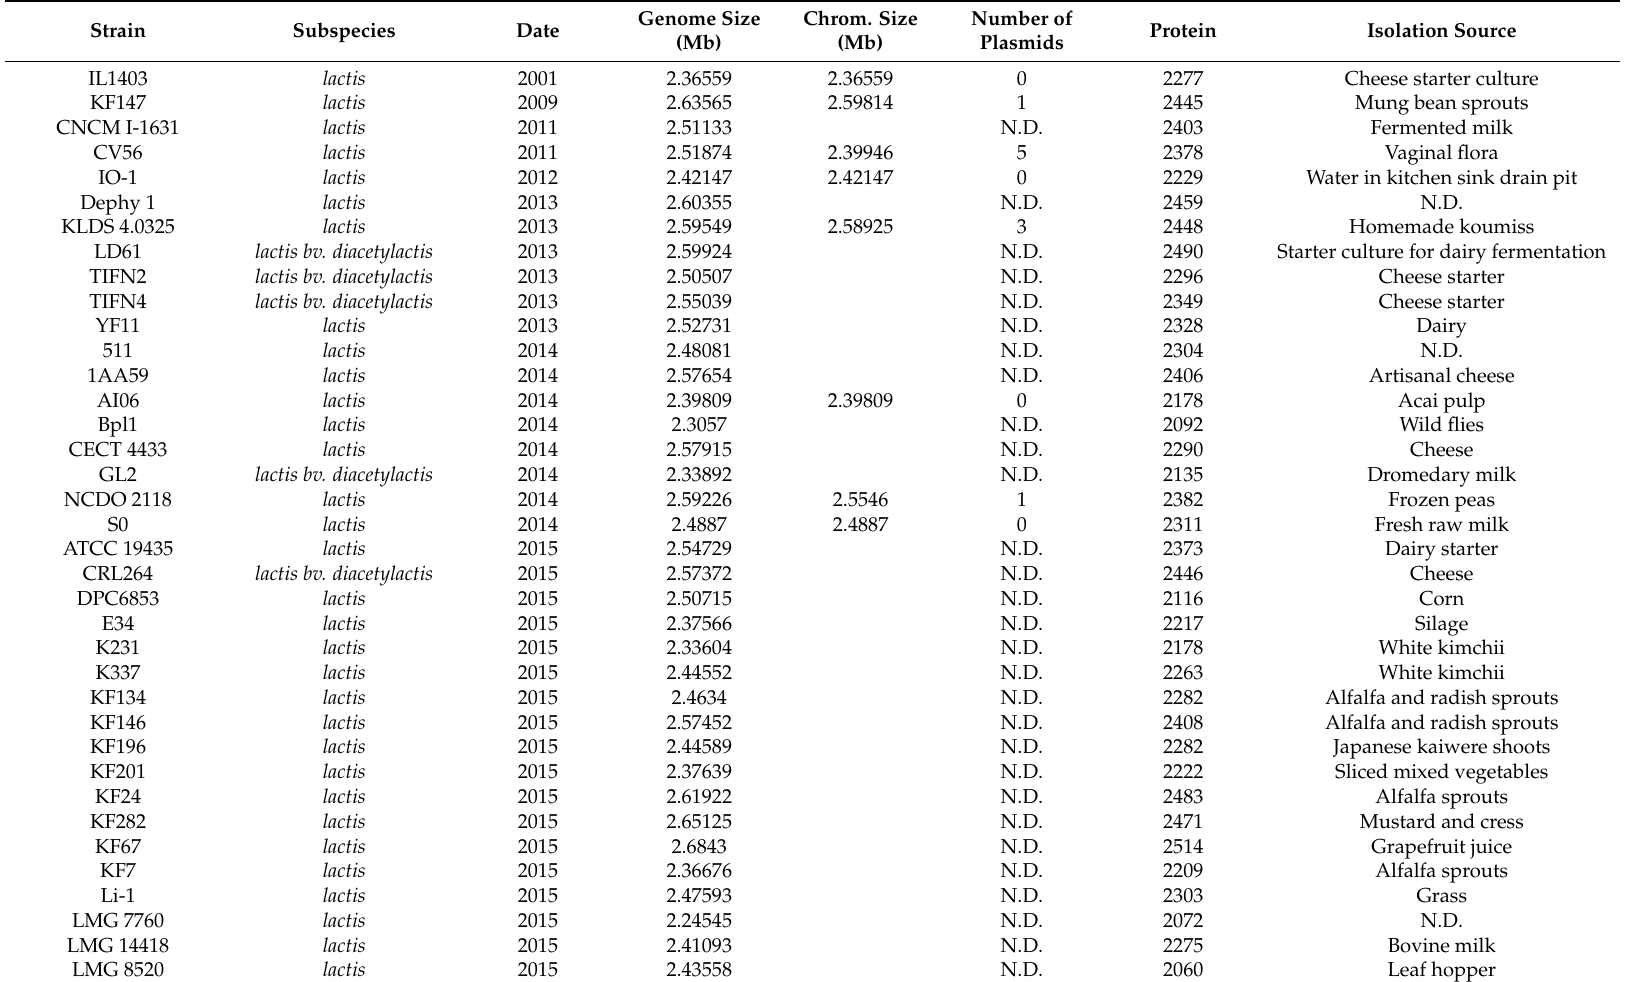
Table 1. Eighty-three available Lactococcus lactis genomes. The data was collected from National Center for Biotechnology Information (NCBI); accessed 18 January 2017 (https://www.ncbi.nlm.nih.gov/genome/genomes/156?); N. D.: not